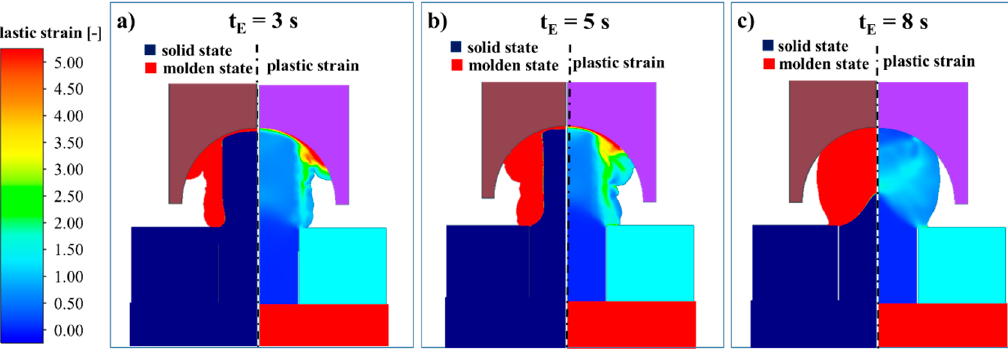
Figure 11. Basic simulation setup at the beginning ( a ) and at the end of the process ( b ).